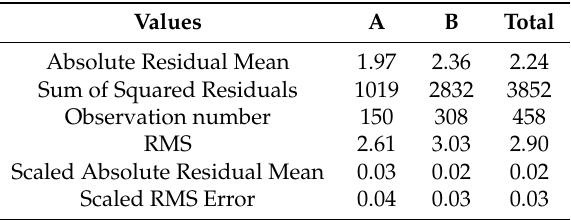
Table 5. Statistics relative to each simulated